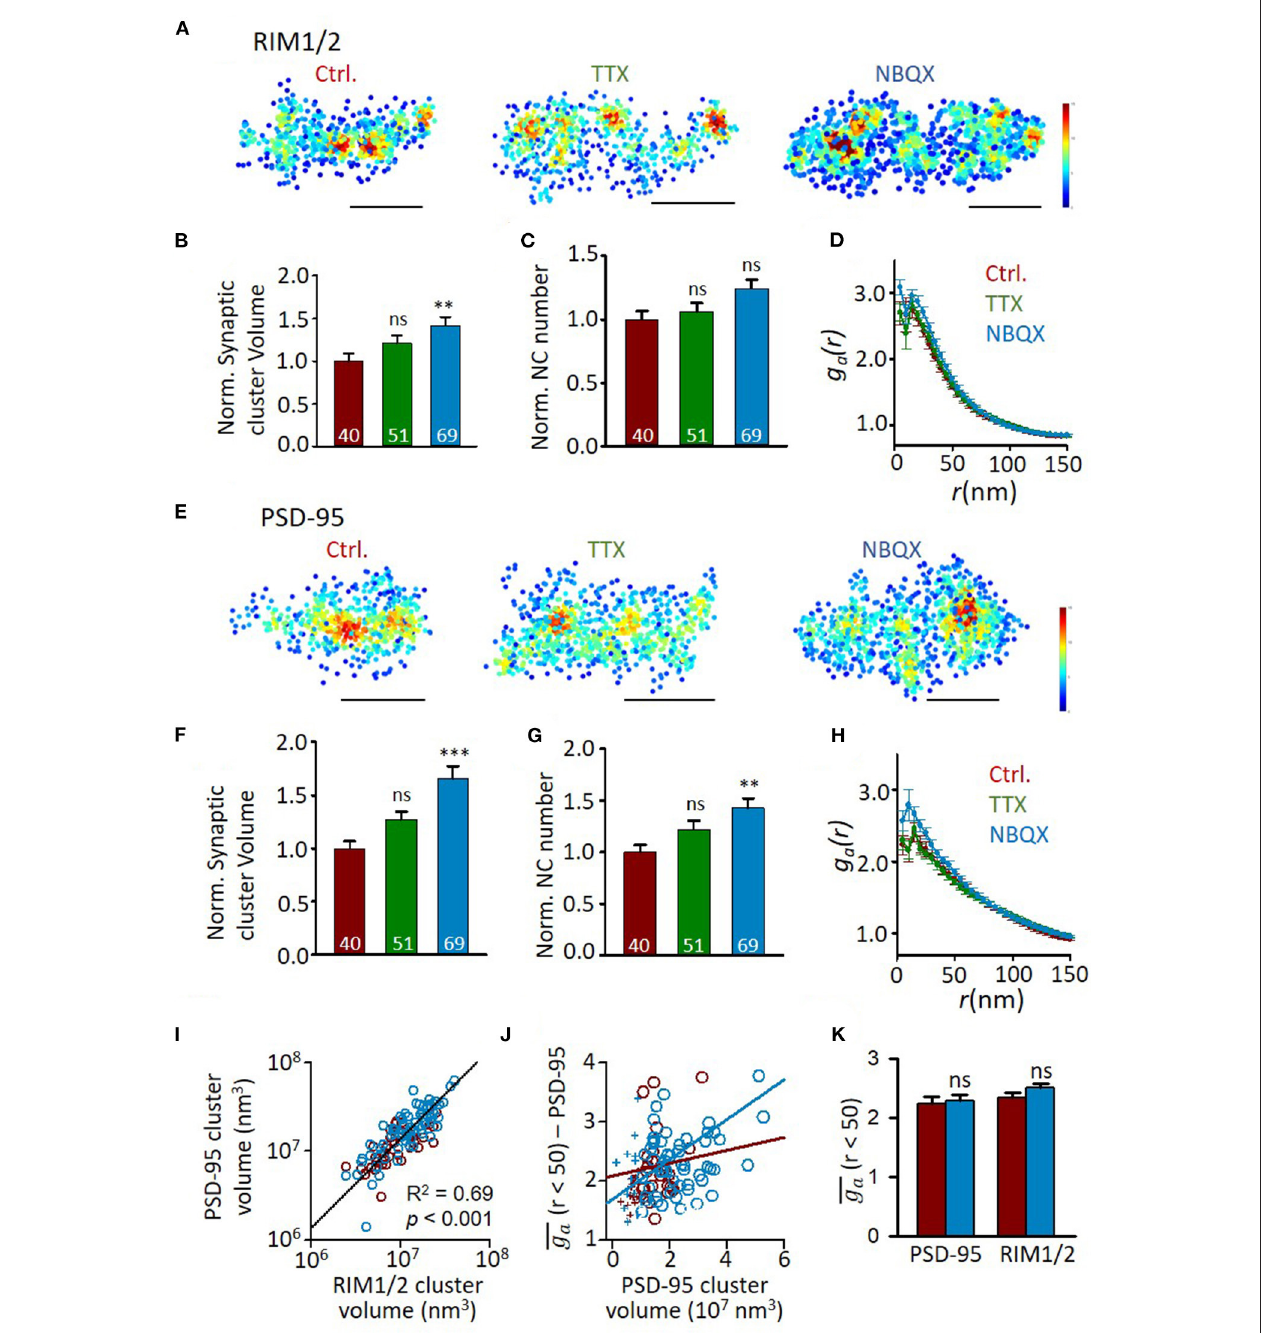
FIGURE 5 | Effects of activity blockade on development of synaptic nano-organizations. (A) Representative density maps of RIM1/2 by STORM in cultures with different activity levels. Scale bar, 200nm. (B–D) Comparison of synaptic cluster volume (B) , nanocluster number (C) , and auto-correlation profile (D) between RIM1/2 distributions from normal DIV18 neurons and cultures with activity blocked with TTX or NBQX. Numbers in bars denote the synapse numbers. (E) Example density maps of PSD-95 in cultures with different activity levels. Scale bar, 200nm. (F–H) Properties of PSD-95 clusters and nanoclusters in synapses from normal DIV18 neurons and cultures with activity blocked with TTX and NBQX. (I) Correlation between the volumes of RIM1/2 and PSD-95 clusters within the same synapses. Linear regressions were conducted on synapses from all three groups. (J) Relationship between heterogeneity and cluster volume of PSD-95 in control (dark red) and NBQX group (blue). Data points with cluster volume > 1 × 10 7 nm 3 were fitted with linear functions. (K) Averaged g a of synapses with cluster volume of 1–3 × 10 7 nm 3 for control (dark red) and NBQX treated cultures (blue). ** p < 0.01, *** p < 0.001, one-way ANOVA with Tukey’s multiple comparisons. Also refer to Supplementary Table 1 for more statistical details. All experiments were repeated ≥ 3